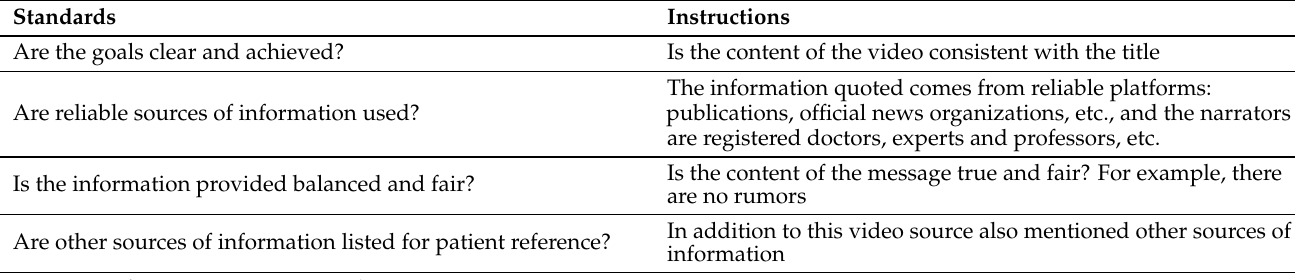
Table 3. Modified DISCREN evaluation